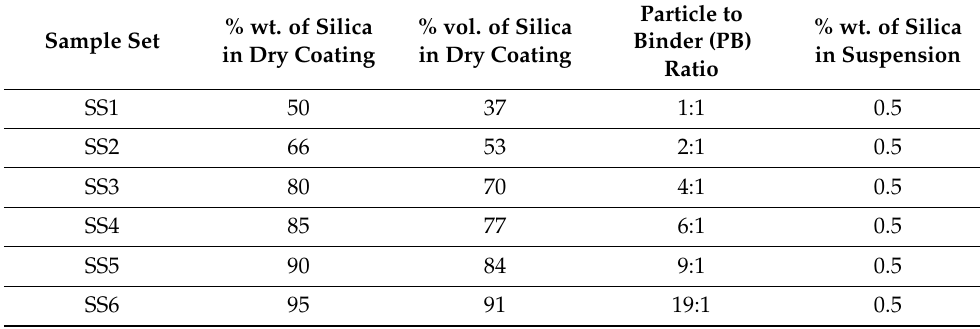
Table 1. Coating